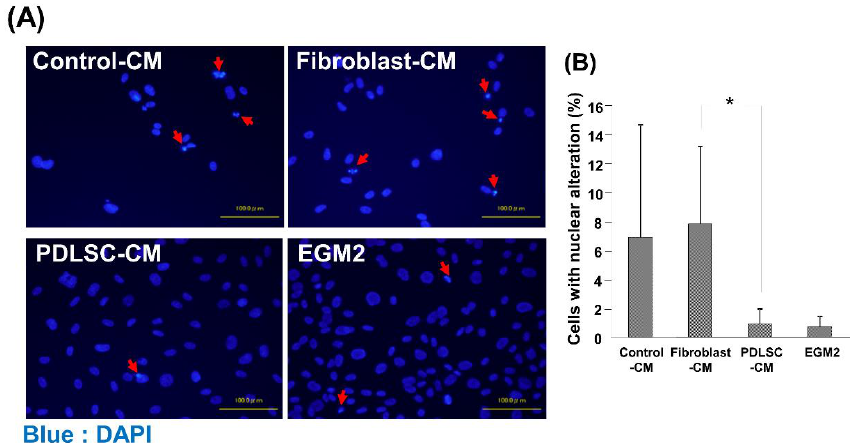
Figure 3. Cell death of HUVECs cultured in various CMs. Representative images of HUVECs with alterations in nuclear morphology after DAPI staining are shown, including nuclei fragmentation and condensation ( A ). The number of HUVECs with nuclear alteration was quantified ( B ). A lower number of cells with alterations of nuclear morphology was identified in HUVECs cultured with PDLSC-CM, compared to Control-CM and Fibroblast-CM. Red arrows: alterations of nuclear morphology (* p < 0.05) (HUVECs = human umbilical cord vein endothelial cells, DAPI = 4′,6-Diamidino-2-phenylindole dihydrochloride, CM = conditioned medium, PDLSCs = periodontal ligament stem cells, EGM2 = endothelial cell growth medium 2). Data from an independent experiment performed three times were shown. ( n = 3).